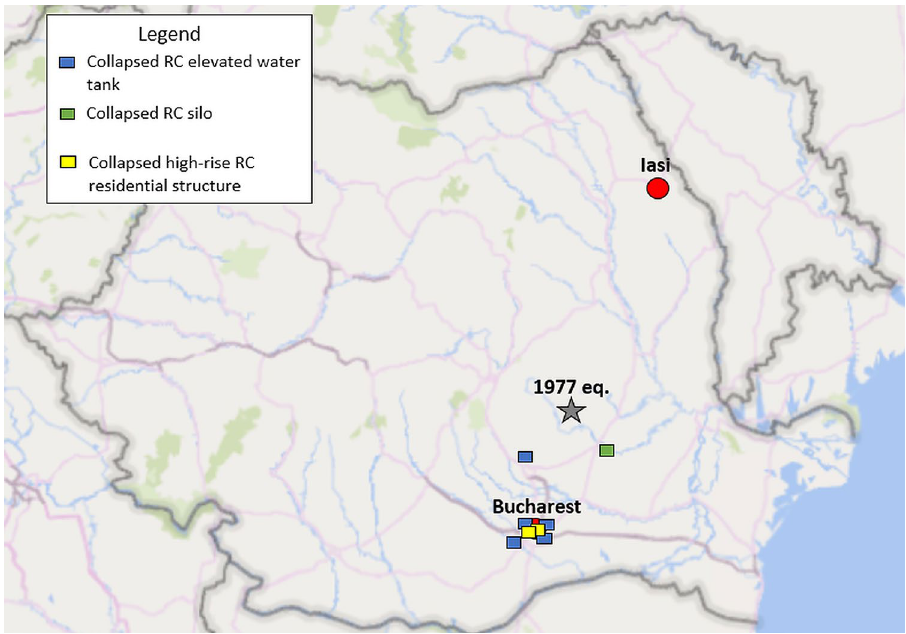
Fig. 1 Locations of collapses structures (RC elevated water tanks, RC silo and high-rise RC residential structures)